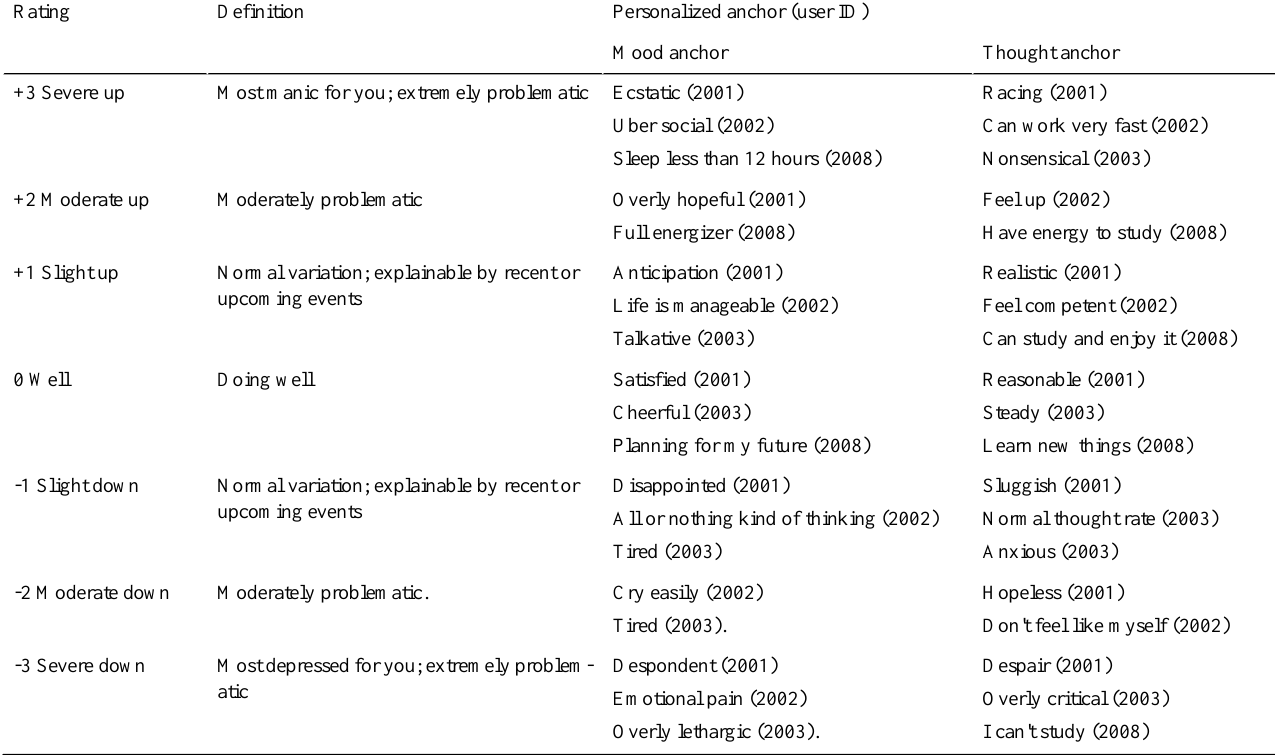
Table 1. Field trial: mood and thought rating scales (n=4).